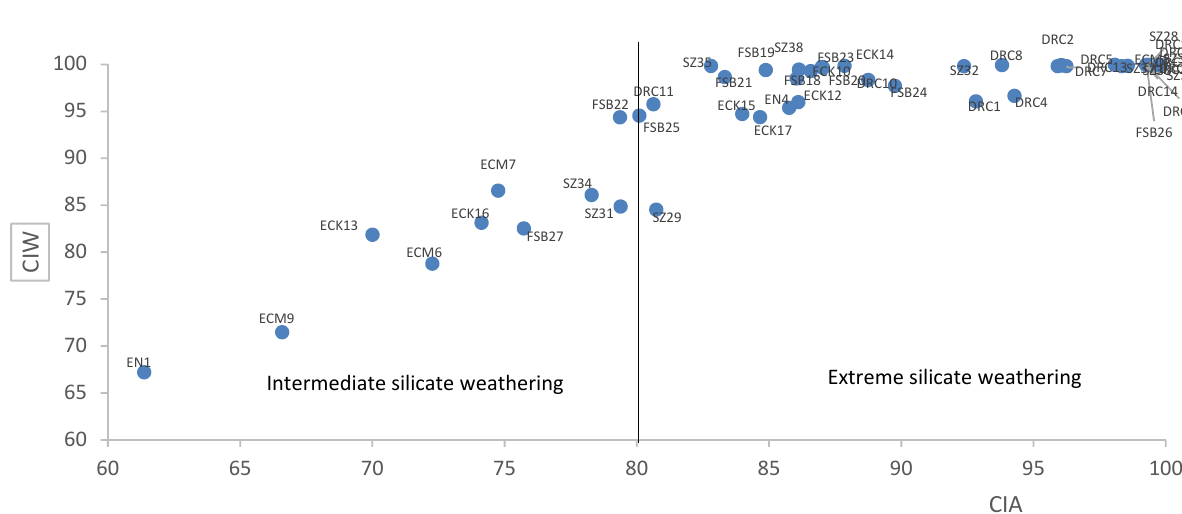
Figure 4. Plot of Chemical Index of Weathering against Chemical Index of Alteration of studied soil